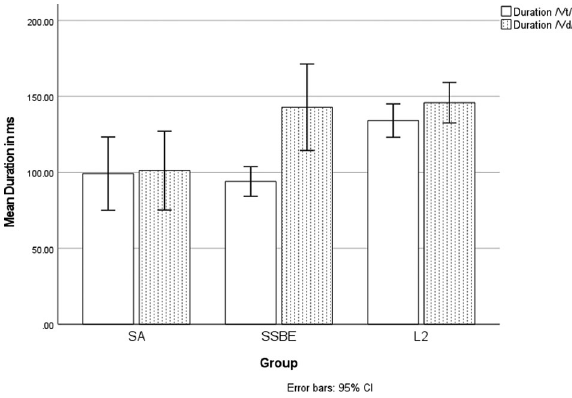
Fig. 1 Vowels Duration. Mean vowel duration before /t/ and /d/ for all speaker groups. Table 1 Mean and standard deviation (between brackets) of durational contrast ratio for all speaker groups.